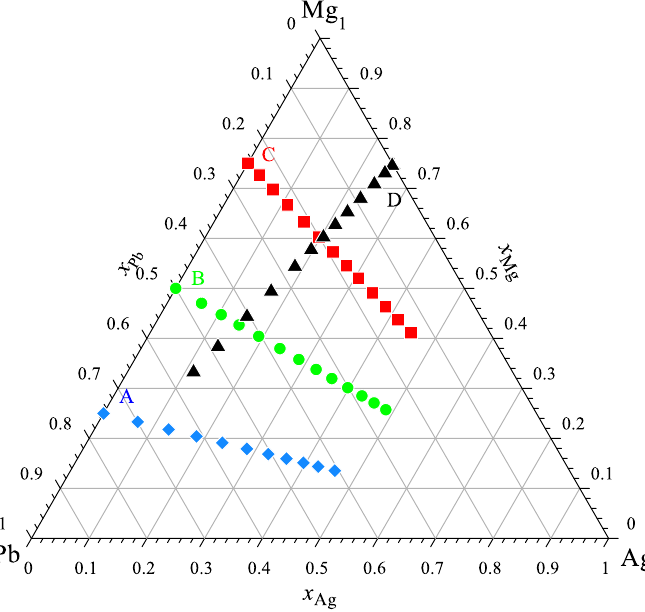
Figure 1. The studied compositions of alloys from the Ag-Mg-Pb system. The calorimetric studies were performed at 1116 K for four series with constant ratios of x Mg / x Pb and x Ag / x Mg, as mentioned above. The obtained experimental values of the heat effects, the integral molar mixing enthalpy of liquid Ag – Mg – Pb alloys, the mole fraction of elements, the drop enthalpies and other information measured in these studies are listed in Tables 2 and 3. Table 2. The integral mixing enthalpy of (Mg 0.25 Pb 0.75 ) 1−x Ag x , (Mg 0.50 Pb 0.50 ) 1−x Ag x , and